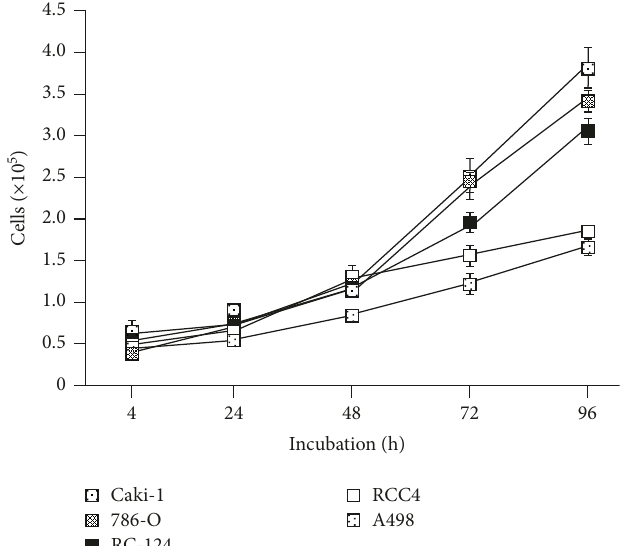
Figure 1: Cellular growth of the RCC cell lines Caki-1, 786-O, RCC4, and A498 as well as the nonmalignant renal cell line RC-124. Cellular growth was examined at indicated time points utilizing a CASY Cell Counter and Analyzer Model TT (Roche Applied Science). Results are expressed as the mean ± SD of cell